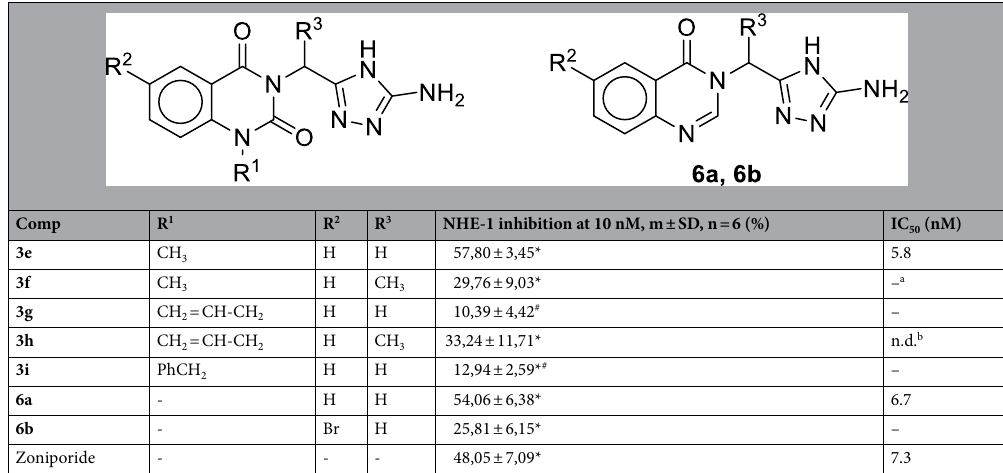
Table 2. NHE-1 inhibition by novel quinazoline-2,4(1 H ,3 H )-dione and quinazoline-4(3 H )-one derivatives with cyclic guanidine moiety. Statistical significance: * p < 0,05 vs. negative control; # p < 0,05 vs. Zoniporide (1-way ANOVA). a Not tested. b Not determined.